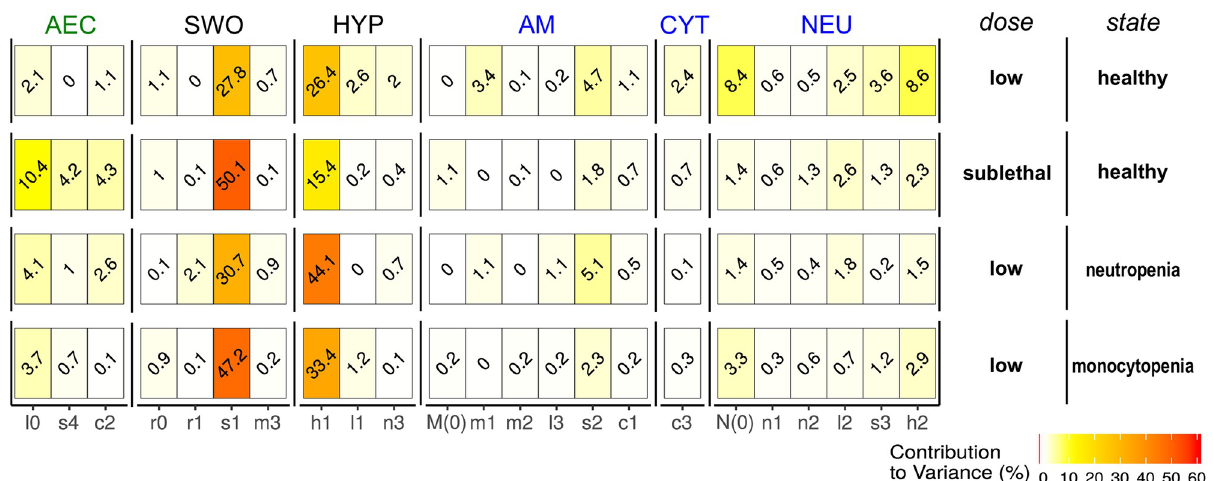
Fig 3. Influence of parameters on the outcome of infection depicted by the contribution to variance (colored from white, yellow to red from no to high influence). This relative contribution is based on a Spearman rank correlation of the parameter value and the objective value of the optimal solution (see Materials and methods, Subsection Solving the optimization problem and parameter sensitivity). Parameters are grouped based on their relation to cell types: alveolar epithelial cells (AEC), resting (RES) or swollen conidia (SWO), hyphae (HYP), alveolar macrophages (AM) and neutrophils (NEU). In addition the cytokine (CYT) property c 3 (decay rate) is listed.